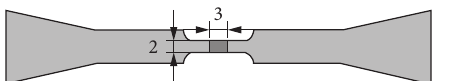
Figure 4: Dimensions of the processing area of the specimen (unit: